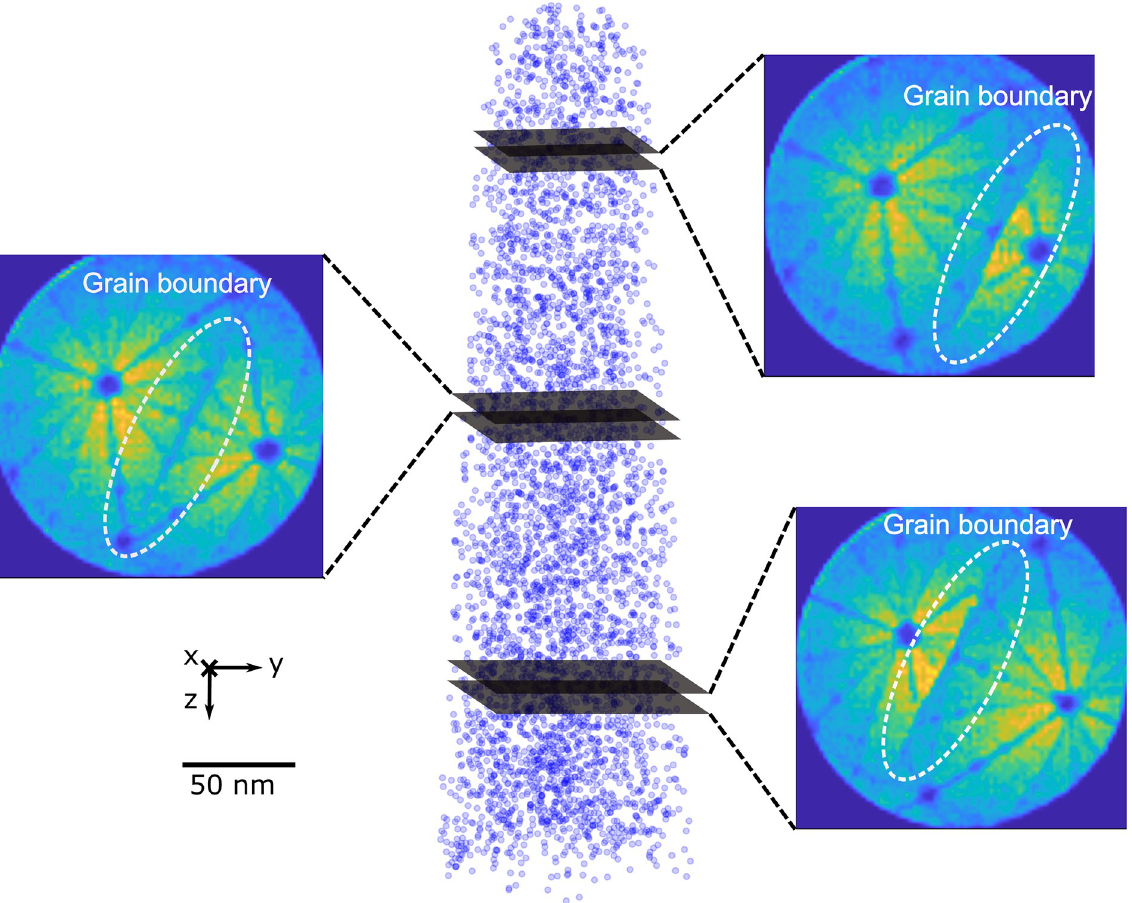
Fig 4. Grain boundary is observed in a series of detector hit map images. The goal is to follow the movement of grain boundary and reconstruct it in 3-D Cartesian space.